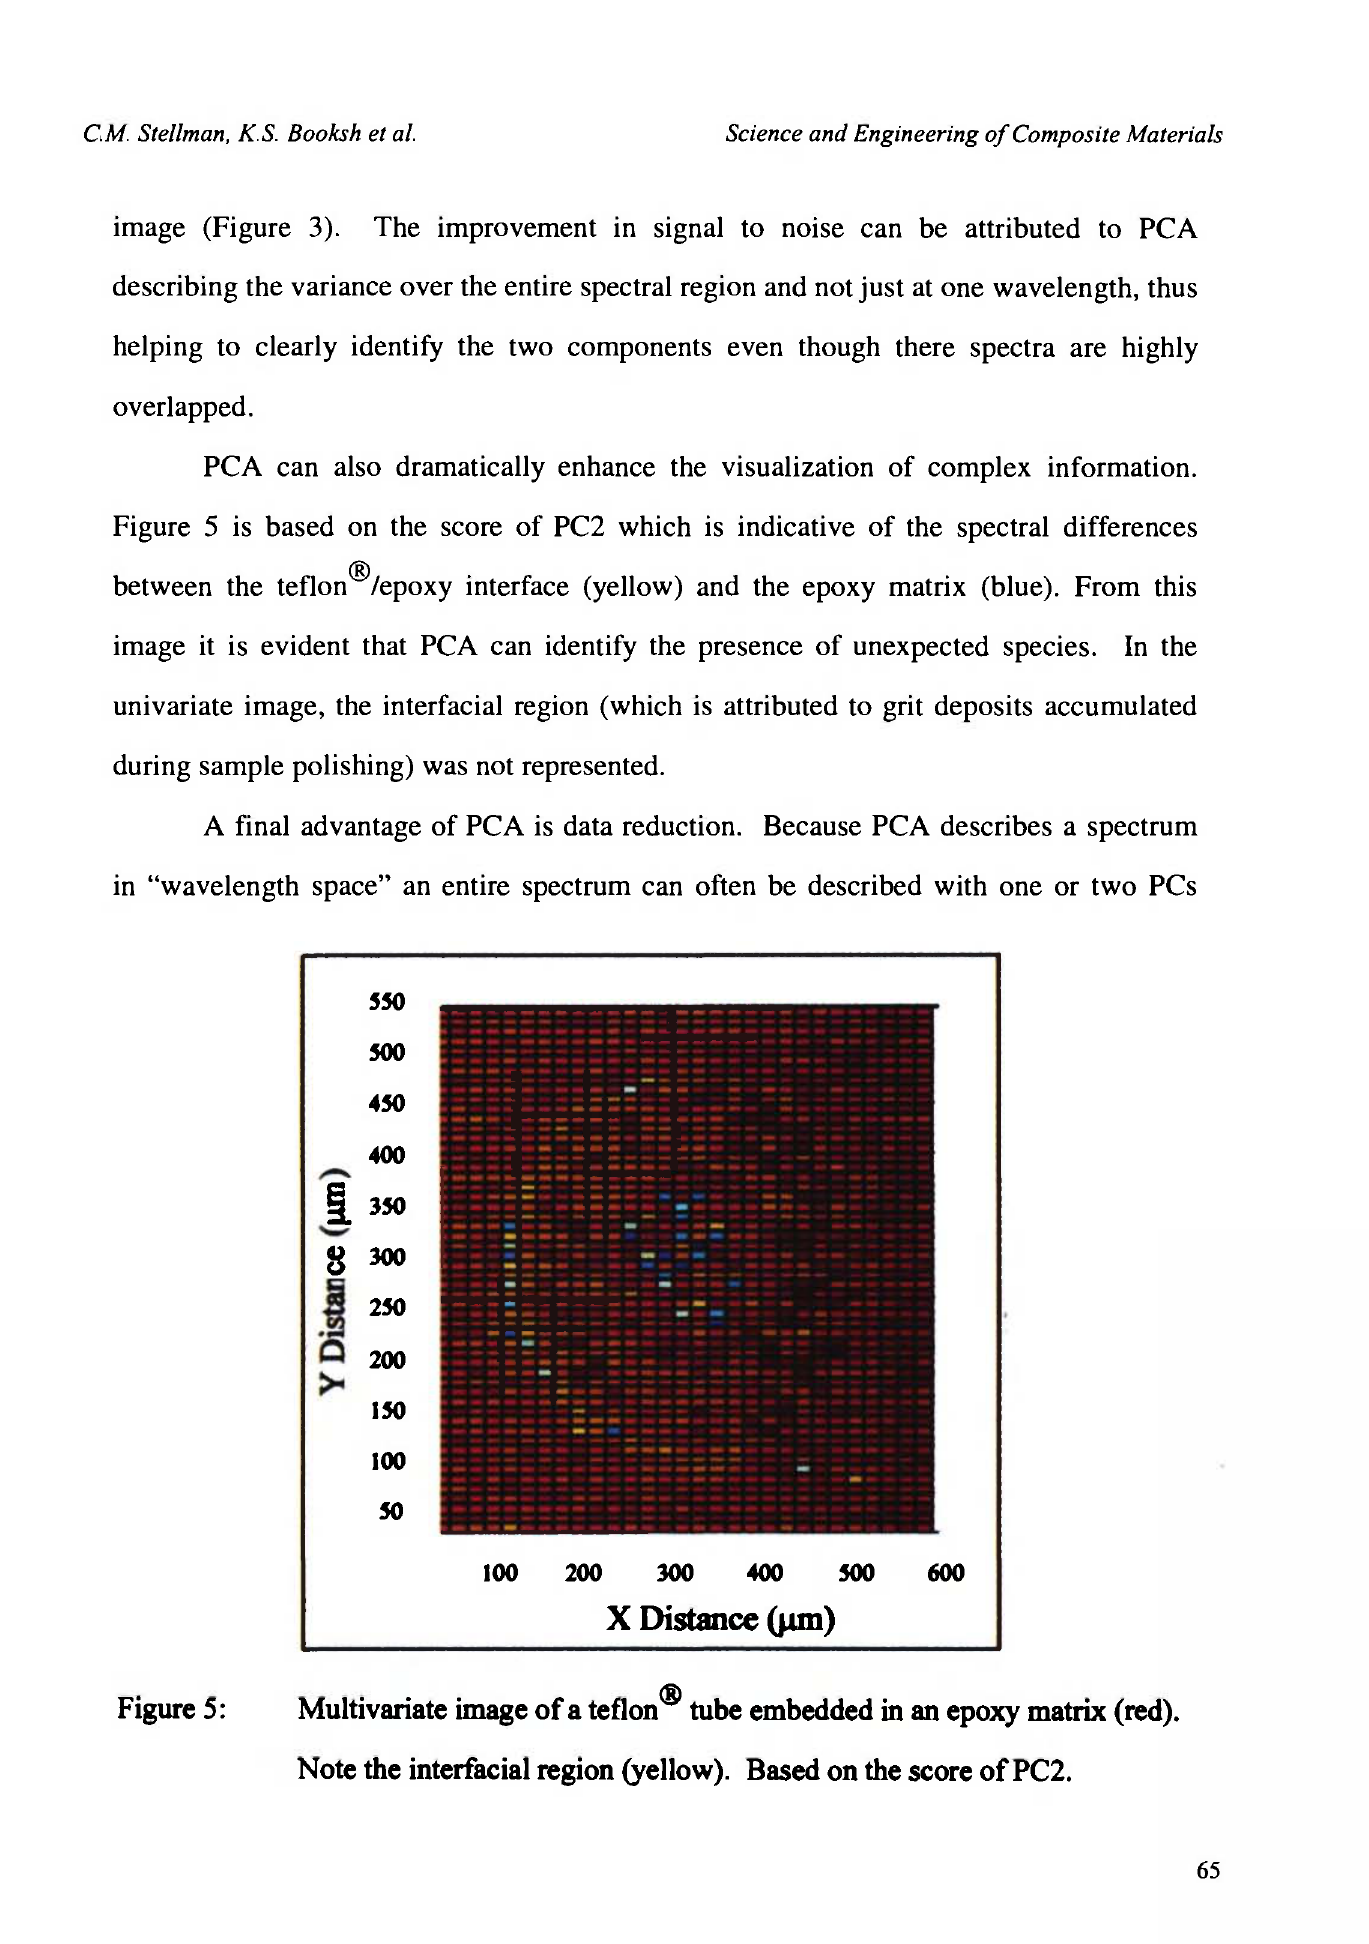
Figure 5: Multivariate image of a teflon tube embedded in an epoxy matrix (red). Note the interfacial region (yellow). Based on the score of